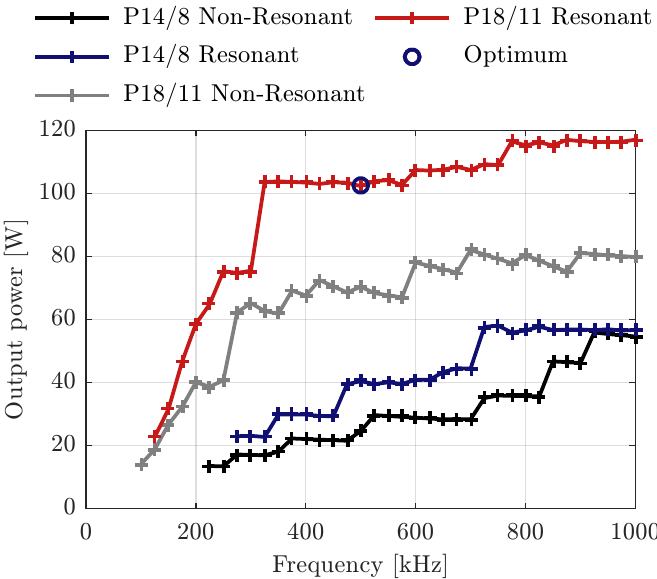
Figure 4. Optimization results: Output power as a function of frequency for all designs.